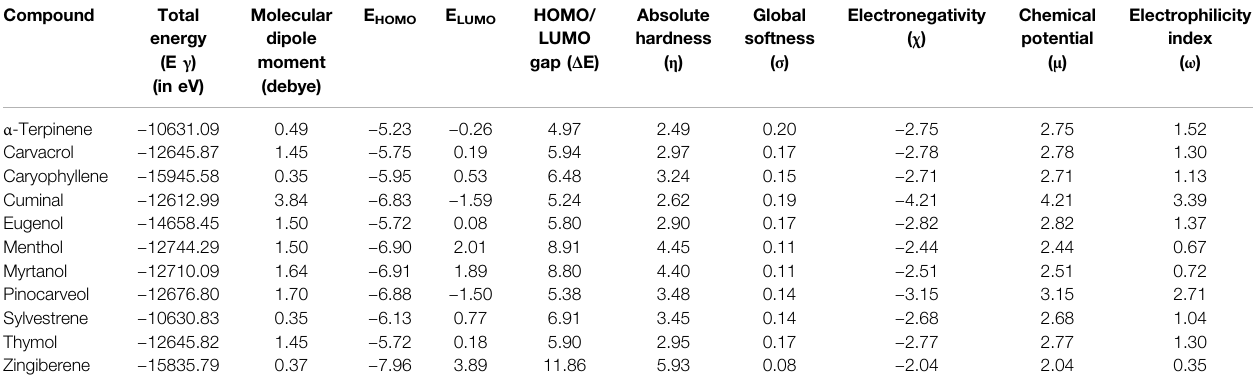
TABLE 3 | Statistics of DFT based molecular descriptors of selected EO components.